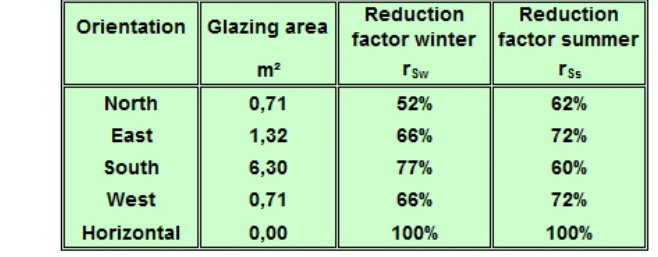
Figure A6. Shading.